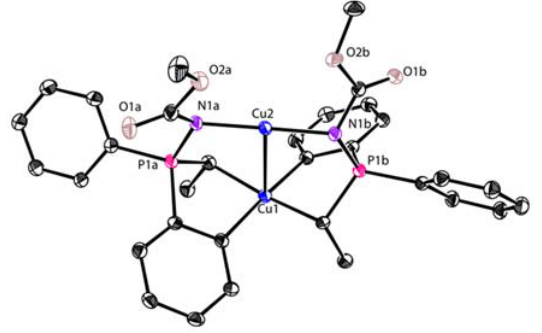
Figure 2. Molecular structure of 15 ; drawn based on [62].